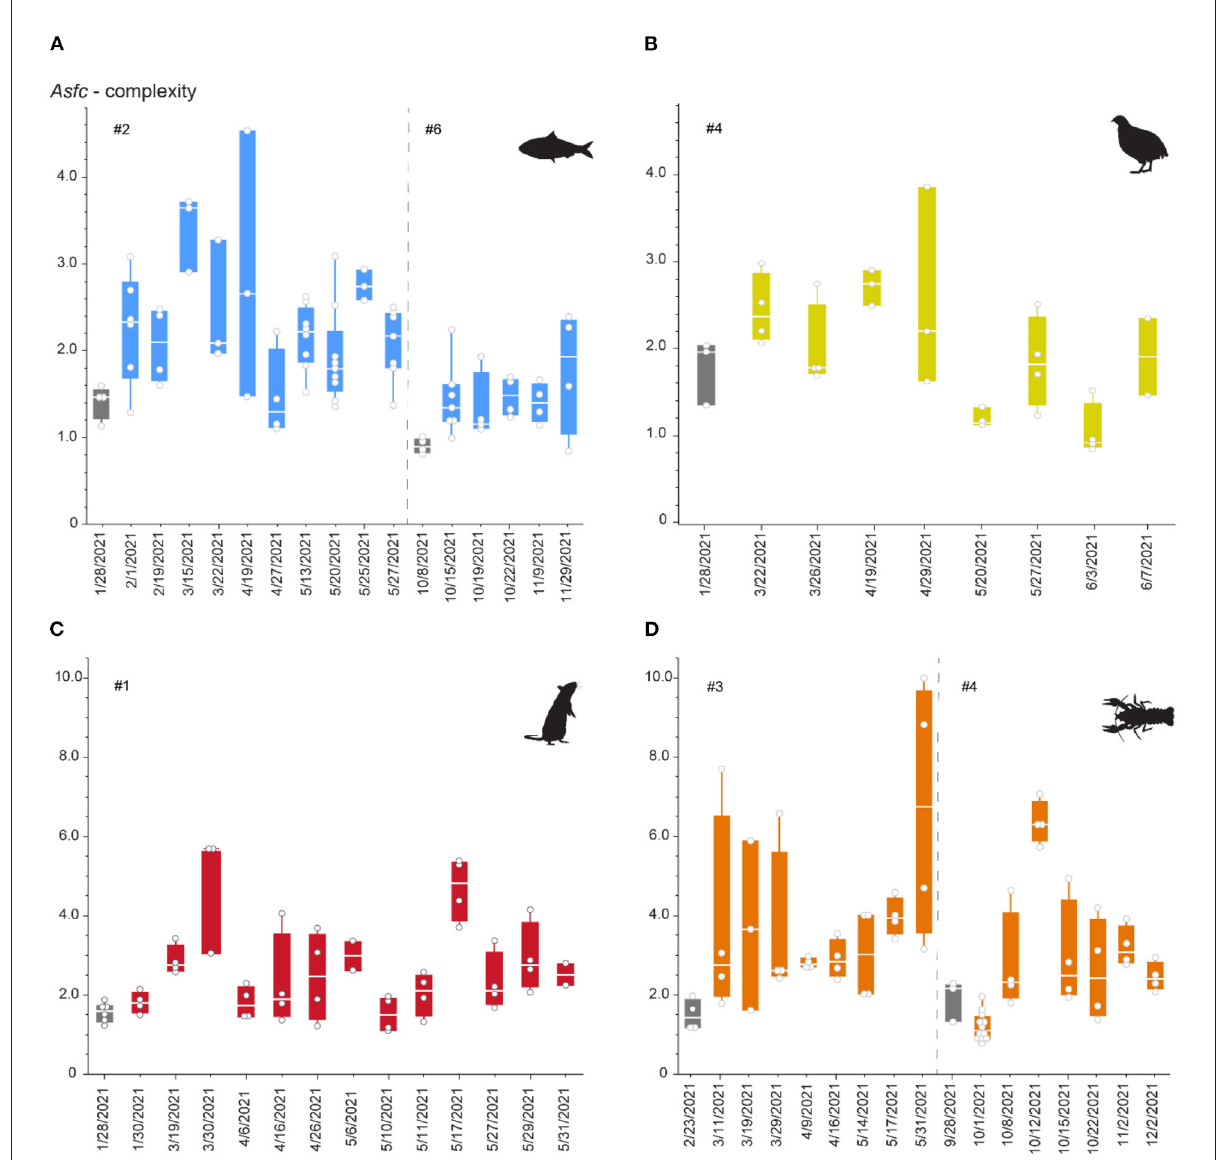
FIGURE5 Asfc over the duration of the first and (for sardine and crawfish) second phase of the feeding experiment. Phases 1 and 2 are separated by a dashed line. Each datapoint represents one scan and can be derived from several teeth collected on the same date. (A) Sardine-feeder (alligators #2 and #6), (B) quail feeder (alligator #4), (C) rat-feeder (alligator #1), (D) crawfish-feeder (alligators #3 and #4). Gray boxplots mark teeth collected before switching to the experimental diet, when the alligator has only consumed pellets for at least 3 months. Note that different scales are used for pairs of sardine-/quail- and